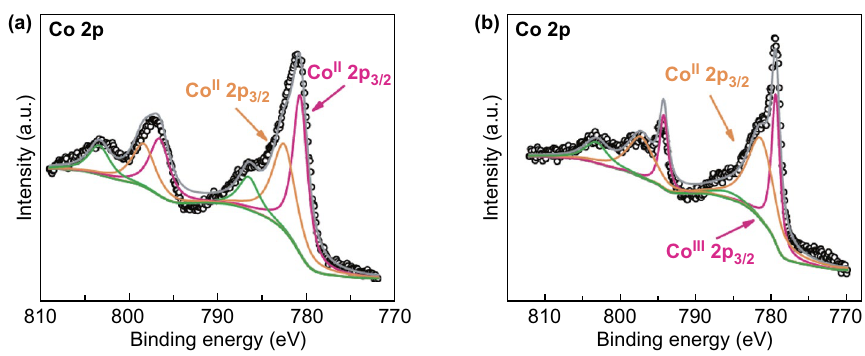
Fig. 4 a Co 2p spectra of Co x S before polysulfide catalysis in a symmetric cell. b Co 2p spectra of Co x S after polysulfide catalysis in a symmet- ric